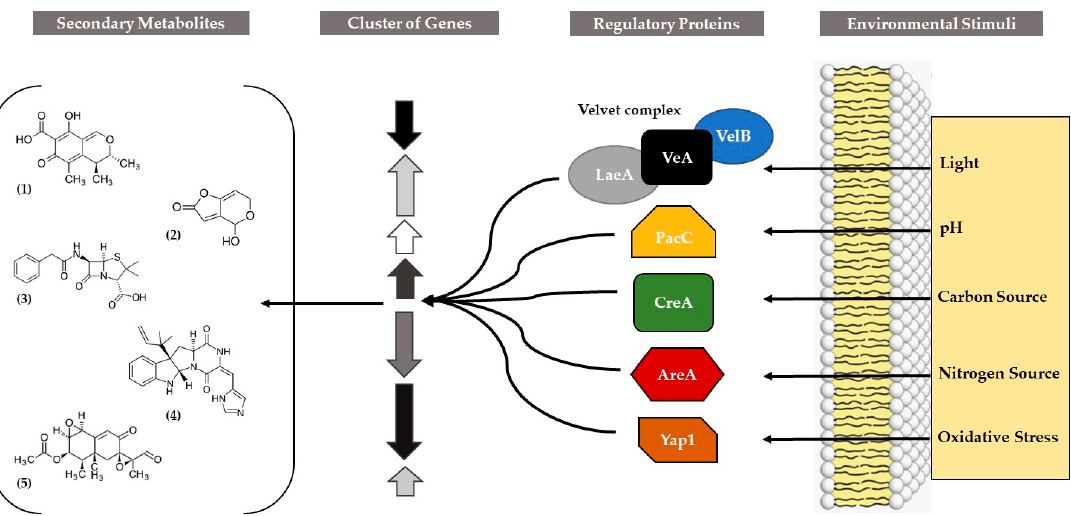
Figure 3. Global regulatory proteins involved in the regulation of gene clusters involved in the production of various secondary metabolites in Penicillium (1) citrinin, (2) patulin, (3) penicillin G, (4) roquefortine C, and (5) PR-toxin, adapted from Brakhage [45].